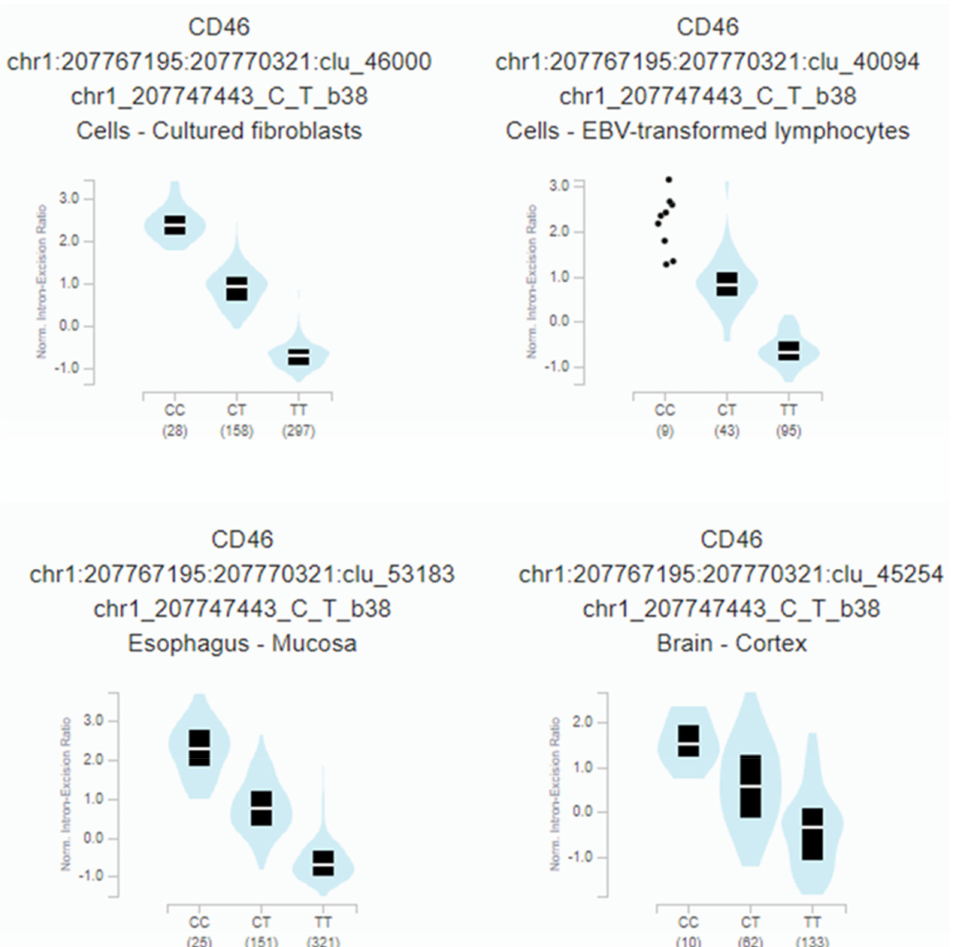
Figure 4. Relationship between the rs2796265 SNP genotypes and the normalized intron-excision ratio in four representative tissues: Fibroblast ( p = 1.4 × 10 − 259 ), esophagus ( p = 1.7 × 10 − 188 ), immortalized B-lymphocytes ( p = 2.1 × 10 − 57 ), brain- cortex ( p = 1.3 × 10 − 25 ). The splicing phenotype IDs are constructed by LeafCutter, and indicate the intron (chr:start:end) and cluster of connected components (clu_) the intron belongs to